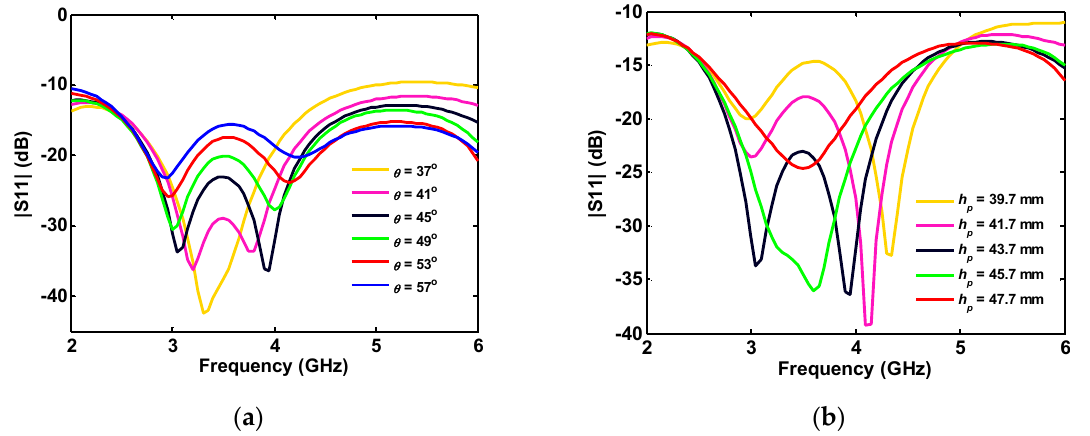
Figure 4. Single-port antenna simulated reflection coefficient in terms of triangle parameters: ( a ) angle; and ( b ) height.